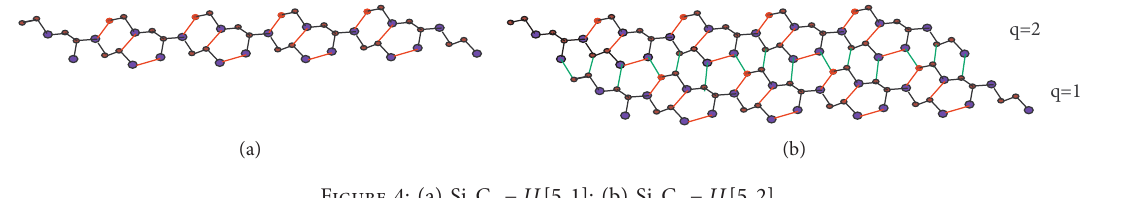
− II [ m,n ] established on degrees C 2 3